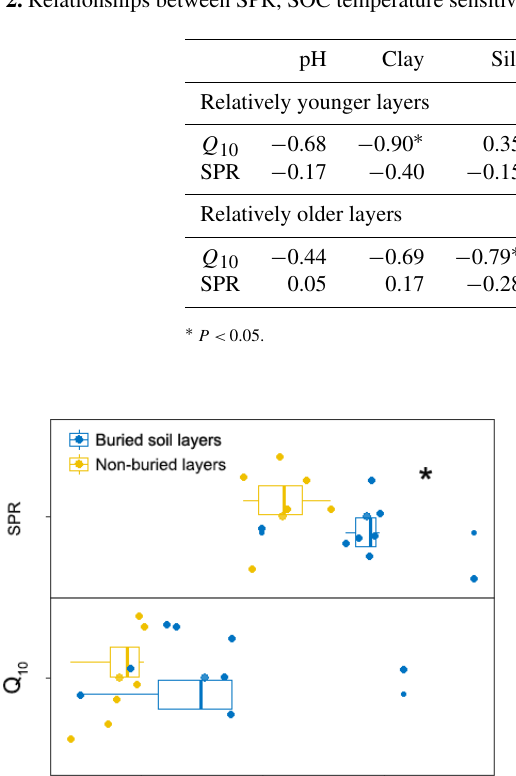
Figure 3. (a) Depth profile of SOC concentration. The significant difference ( P < 0.05) in SOC concentration between the terraced and con- trol soil layers can be found below 50cm layers. There is no such significant difference at 0–50cm layers. (b) Ternary plot of SOC fractions in percentage of total SOC. M = microaggregate-associated SOC; cPOM = coarse particulate SOC; S + C = silt- and clay-associated SOC. Color bar represents the soil depth (cm). Error bars denote 1 standard deviations of the M fraction measurements ( N = 2). Table 2. Relationships between SPR, SOC temperature sensitivity ( Q 10 ), and measured soil geochemical properties.